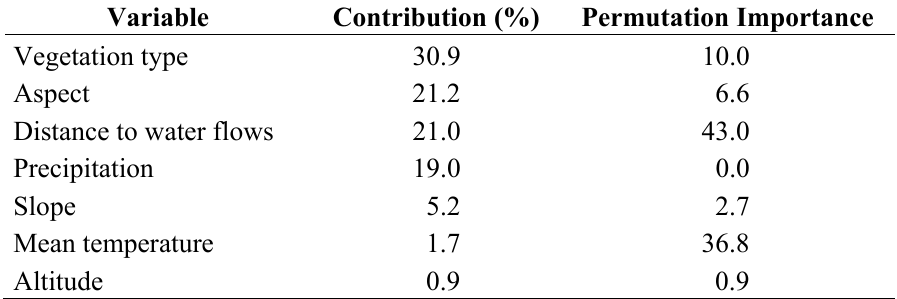
Table 5. Contribution of the variables to the potential distribution of Picea chihuahuana Martínez: model at local